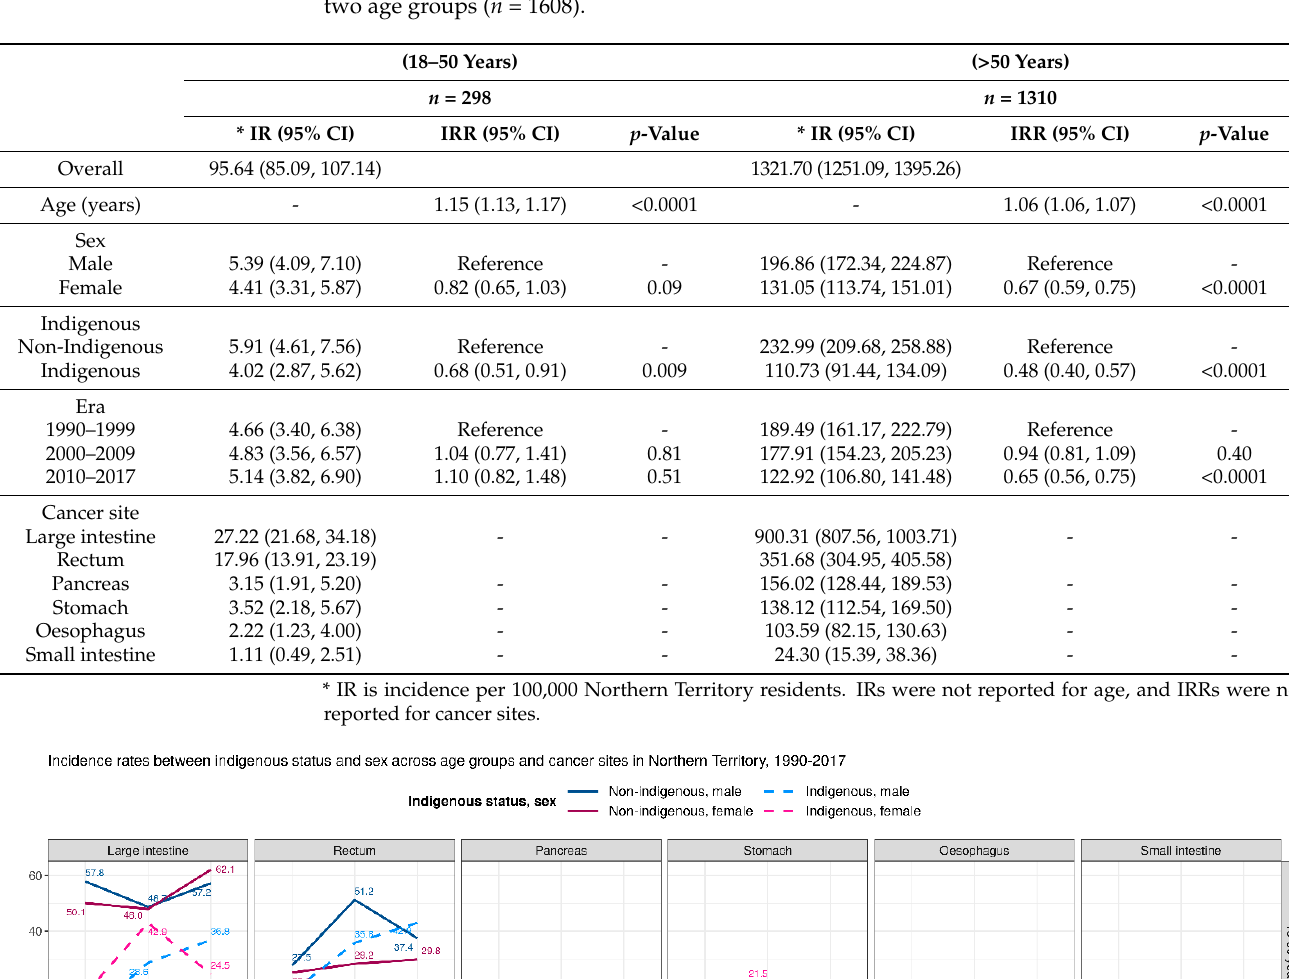
Table 2. Incidence rates (IR) and incidence rate ratios (IRR) for age, sex, era, and cancer sites between two age groups ( n = 1608).